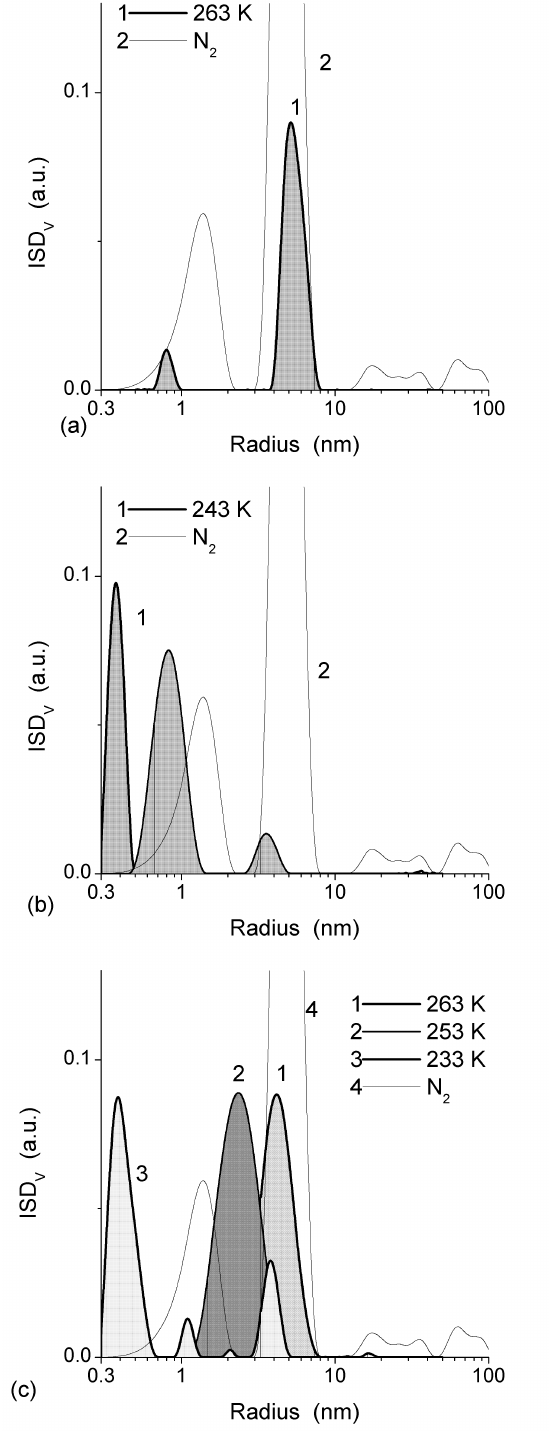
Fig. 7 Incremental size distributions of liquid structures calculated on the basis of CPMG echo decay envelopes for (a and b) benzene and (c) water adsorbed onto SBA-15 as a mixture at h = 0.16 ml/g and b = 0.13 ml/g; IPSD V based on the nitrogen adsorption isotherm is